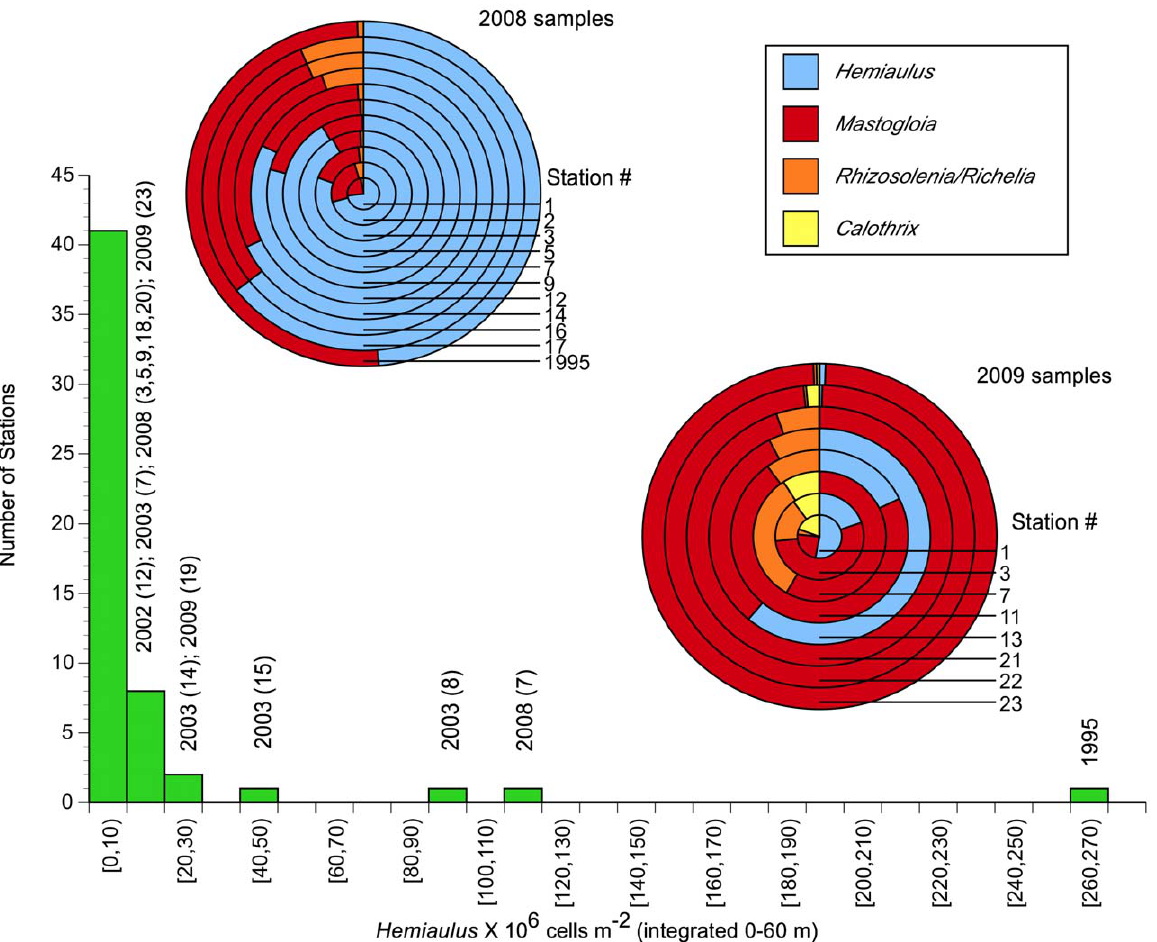
Figure 8. Species/abundance summary for the 2008/2009 blooms. Histograms express 0–60 m integrated abundance values for the DDA Hemiaulus hauckii . Individual columns are labeled with year (station number) for reference to the onion plots. The onion plots express the relative species abundance at stations for each year with each taxon color-coded (see Table 1, 2 for numerical data).